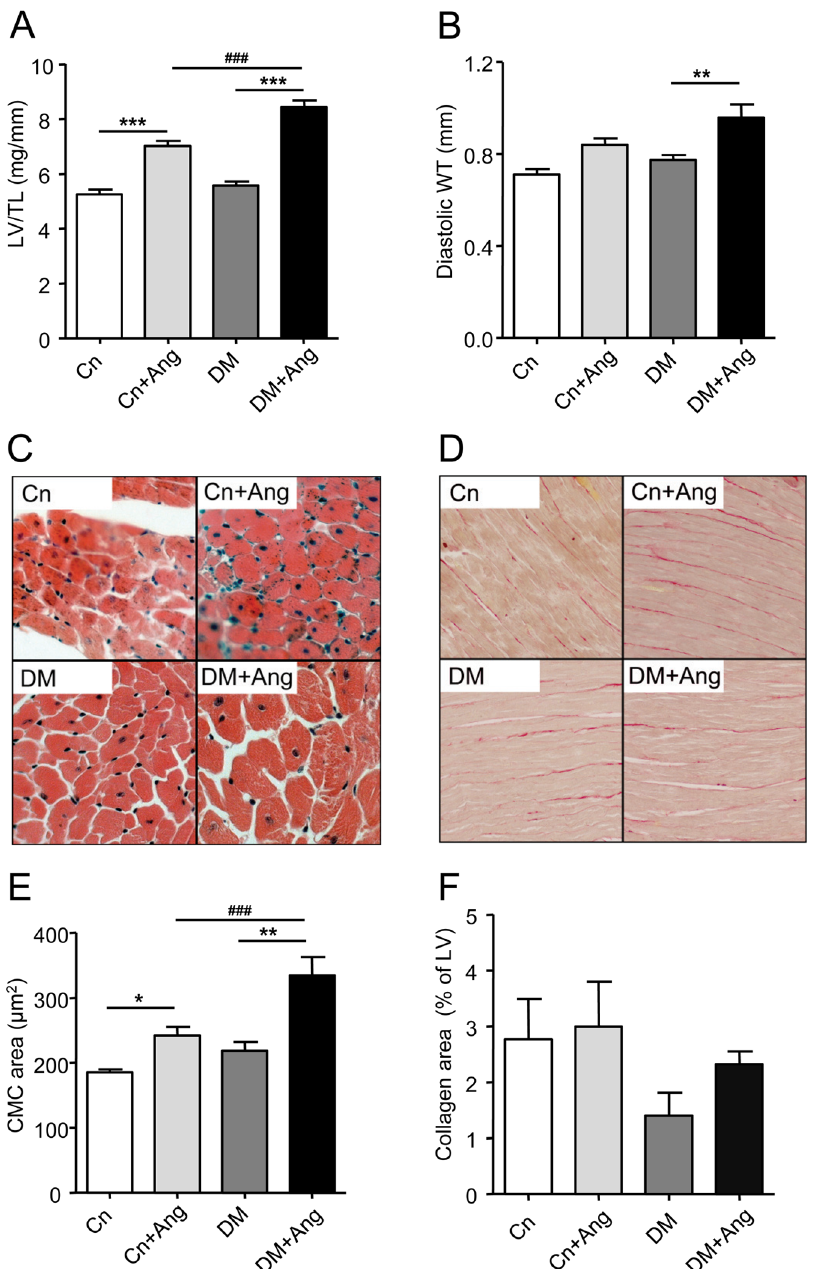
Figure 4. AngII-induced hypertension enhances cardiac hypertrophy in diabetic mice. Cardiac structural remodeling in non-diabetic (Cn) and diabetic (DM) mice treated with vehicle or AngII (Ang) for 4 weeks. Left ventricle weight/Tibia length (LV/TL – Panel A) and diastolic LV wall thickness (WT – Panel B). Representative pictures depicting cardiomyocyte size (C) and extent of fibrosis (D). Quantification of cardiomyocyte cross- sectional surface area (E) and collagen fraction (F). Data are analyzed by one-way ANOVA with Bonferroni post-hoc testing and expressed as mean 6 SEM (n = 7–9 per group). * refers to effect of AngII in non-diabetic and diabetic mice (* P , 0.05, ** P , 0.01, *** P , 0.001) and # refers to effect of diabetes in vehicle-treated and AngII-treated mice ( # P , 0.05, ## P , 0.01, ### P ,